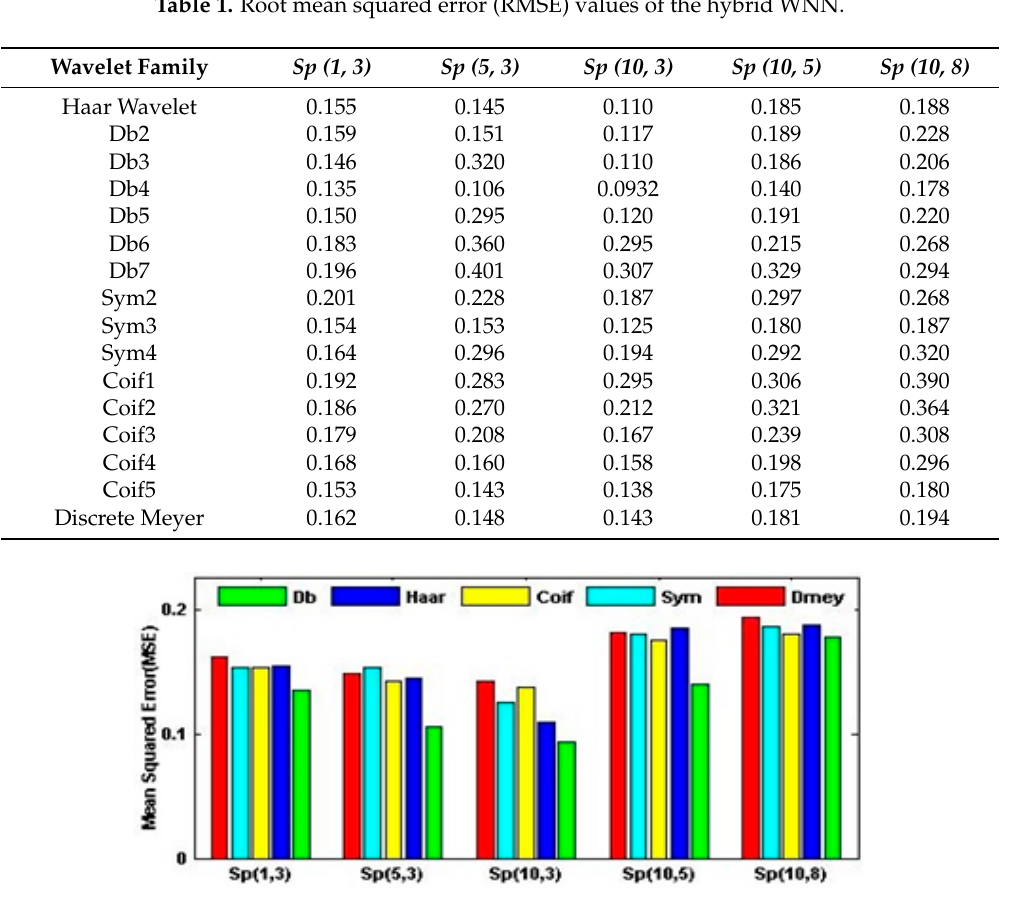
Figure 3. Relative performance of the hybrid WNN model with different wavelets. Table 1. Root mean squared error (RMSE) values of the hybrid WNN.